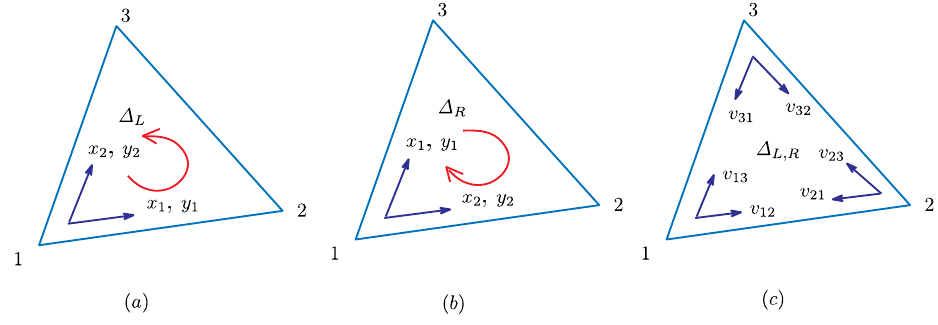
Figure 5. A triangle 123 with the local coordinate axis x i and the tangent vector component y i (= ˙ x i ) at Vertex 1 on the ( a ) left-handed triangle ∆ L and ( b ) right-handed triangle ∆ R ; and ( c ) three possible local coordinates on triangle ∆ L , R and positive number v ij assigned along the bond ij